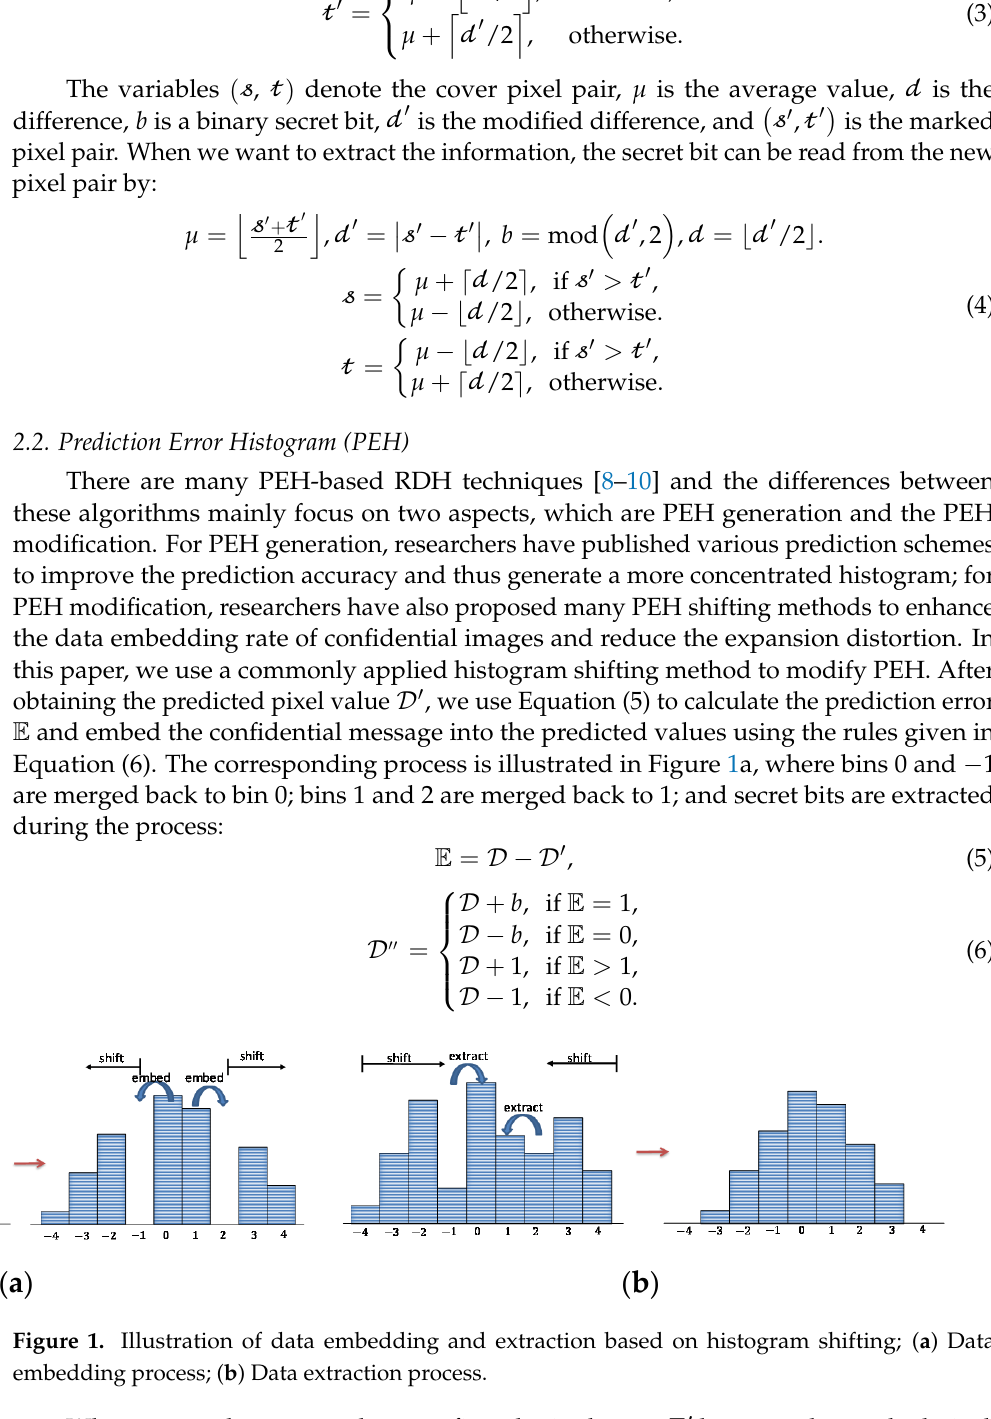
Algorithm 2 Data Embedding for Complex Blocks